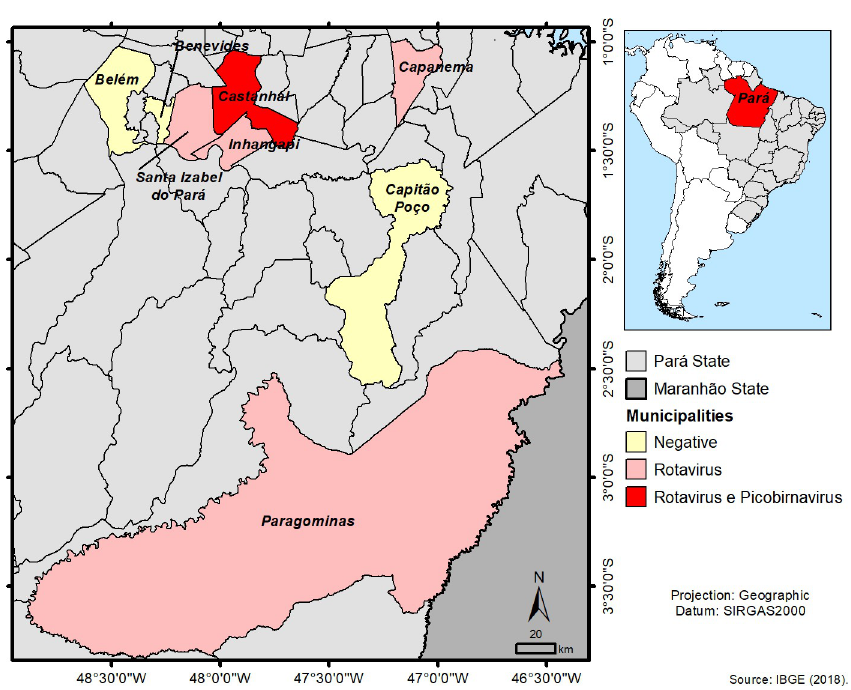
Fig 1. Geographic distribution of positive cases of RV and PBV in wild and exotic birds in the state of Para´. All data were built with public demographic data available on IBGE (Brazilian Institute of Geography and Statistics) with SIRGAS2000 (Geocentric Reference System for the Americas) obtaining coordinates from Para´ state, Brazil and It can be found in https://www.ibge.gov.br/geociencias/organizacao-do-territorio/malhas-territoriais/15774-malhas.html? =&t=downloads.